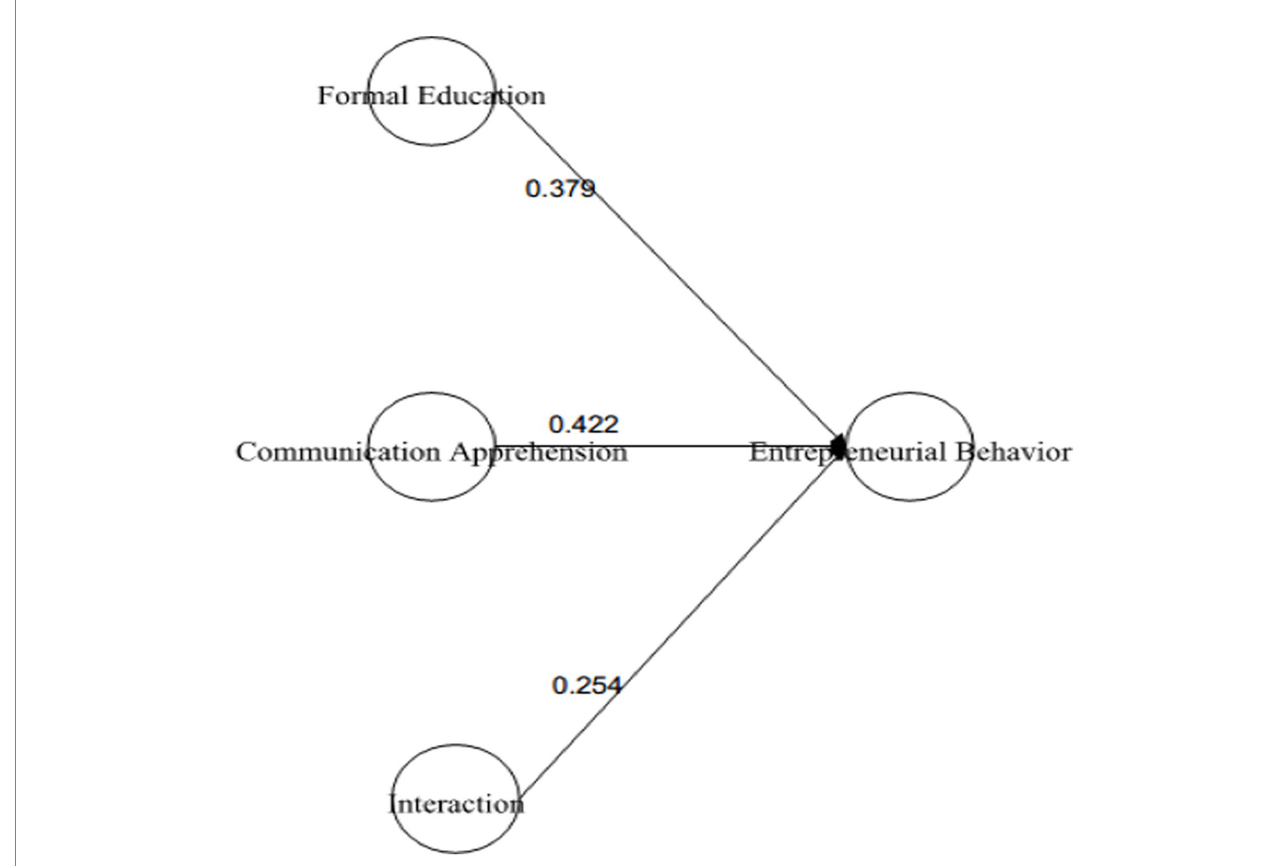
FIGURE 5 Moderating effect of TESOL amplified communication apprehension on the relationship of formal education—entrepreneurial behavior.